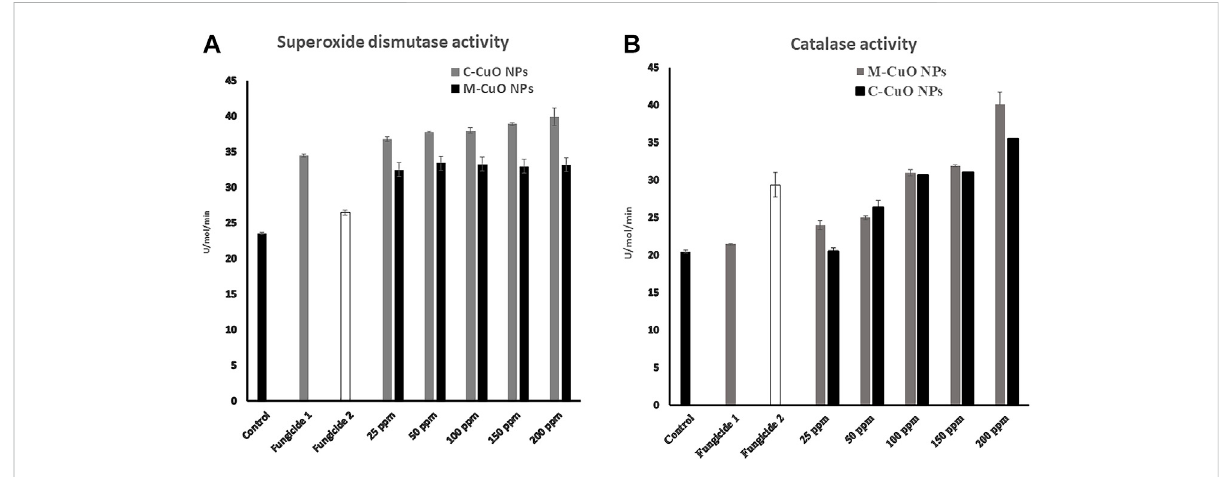
FIGURE 15 Reactive oxygen species enzyme activation in A . brassicae: (A) superoxide dismutase and (B)